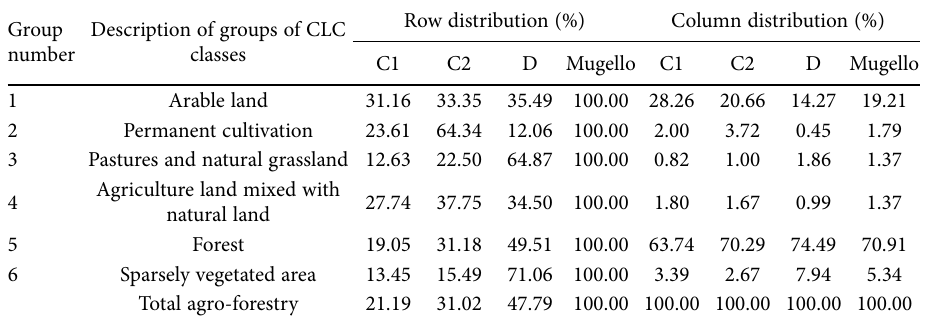
Pastures and natural grassland